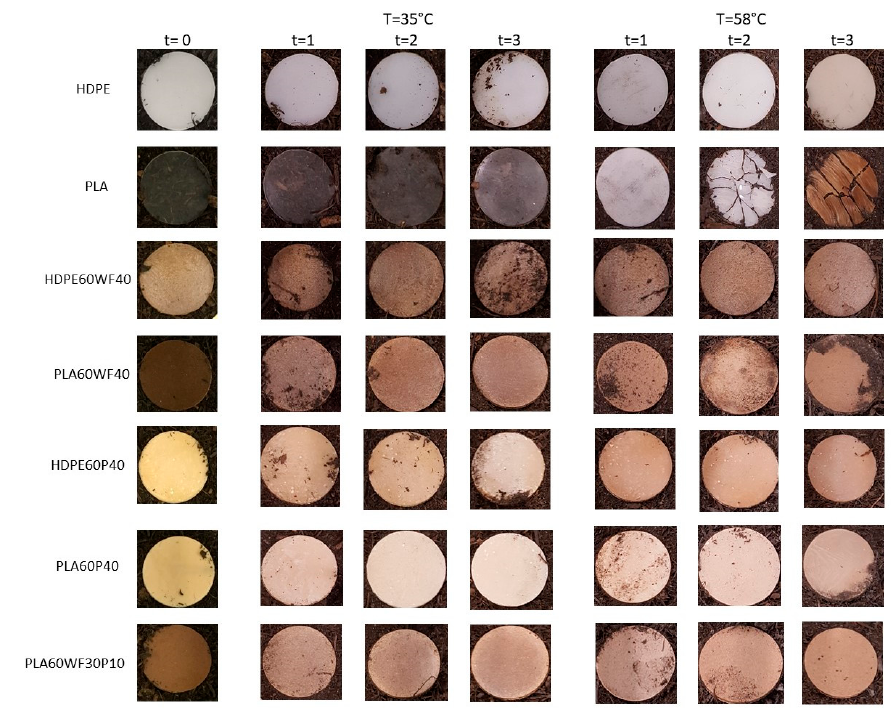
Figure 3. Visual observation of samples at time 0, and after 1, 2 and 3 months buried at 35 °C and 58